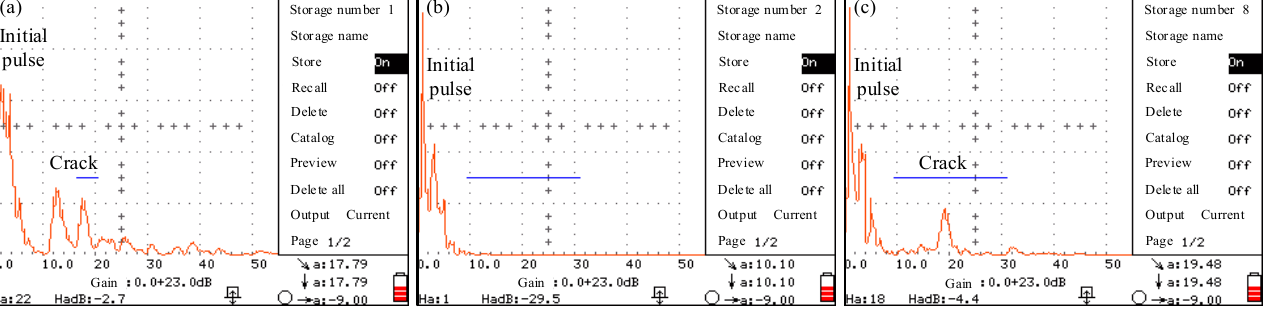
Figure 12. Ultrasonic crack testing results of shear studs of specimen S-3 after 133,000 cycles in the fatigue test: ( a ) stud No. 1; ( b ) stud No. 2; ( c ) stud No. 8.